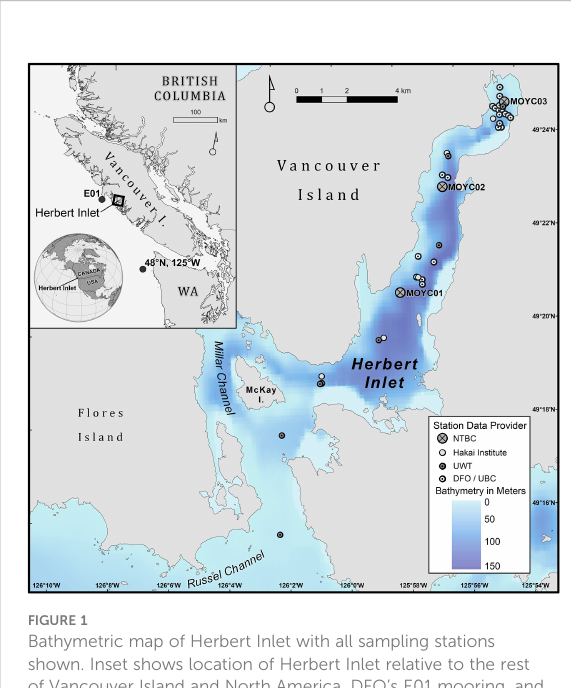
FIGURE 1 Bathymetric map of Herbert Inlet with all sampling stations shown. Inset shows location of Herbert Inlet relative to the rest of Vancouver Island and North America, DFO ’ s E01 mooring, and the location at which Bakun daily Cumulative Upwelling Index (CUI) values were recorded (black